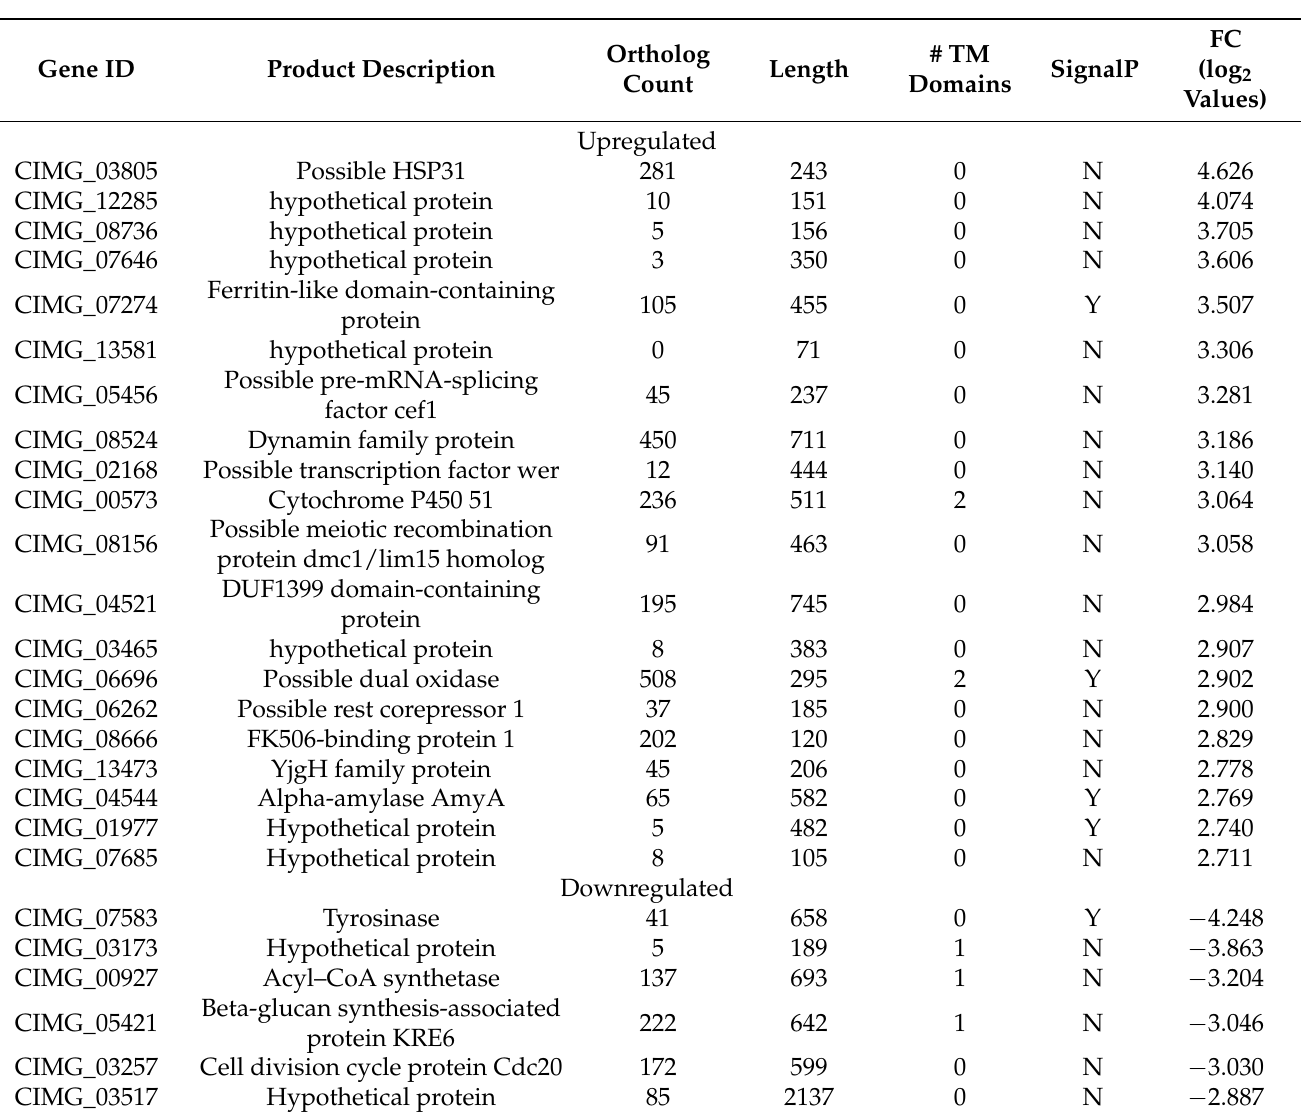
Table 4. Most differentially expressed genes in mature spherules compared to young